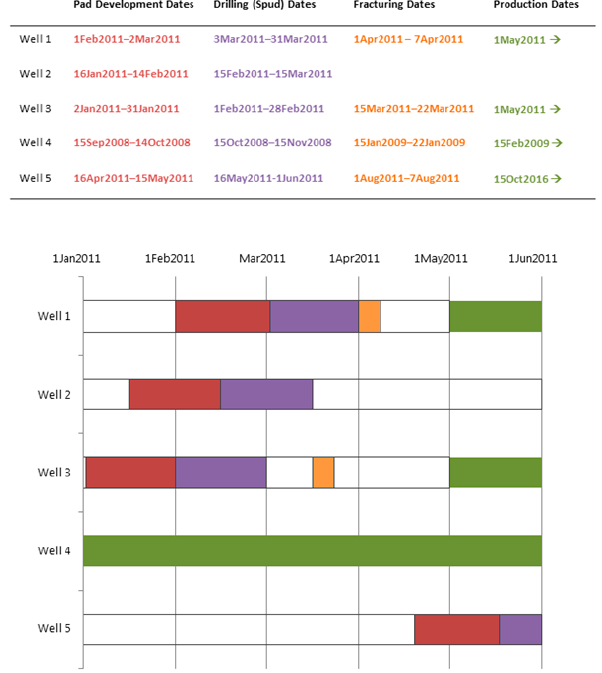
Figure 2. Illustration of how date ranges for phases of well development were used to calculate the four WA metrics. Note that this illustration includes only five of the 8885 wells in the study, and a portion (January to June 2011) of the 5-year study period.